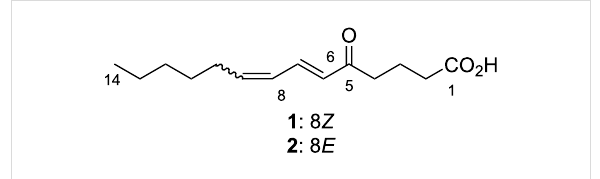
Figure 1: Structures of (6 E ,8 Z )- and (6 E ,8 E )-5-oxo-6,8-tetradeca- dienoic acids ( 1 and 2 ).